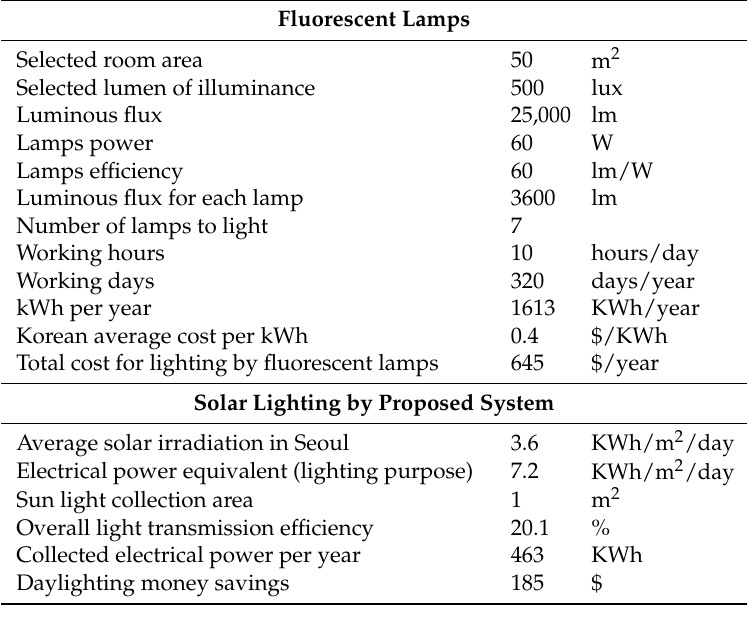
Economic comparison with using of fluorescent lamps and saving considerations by